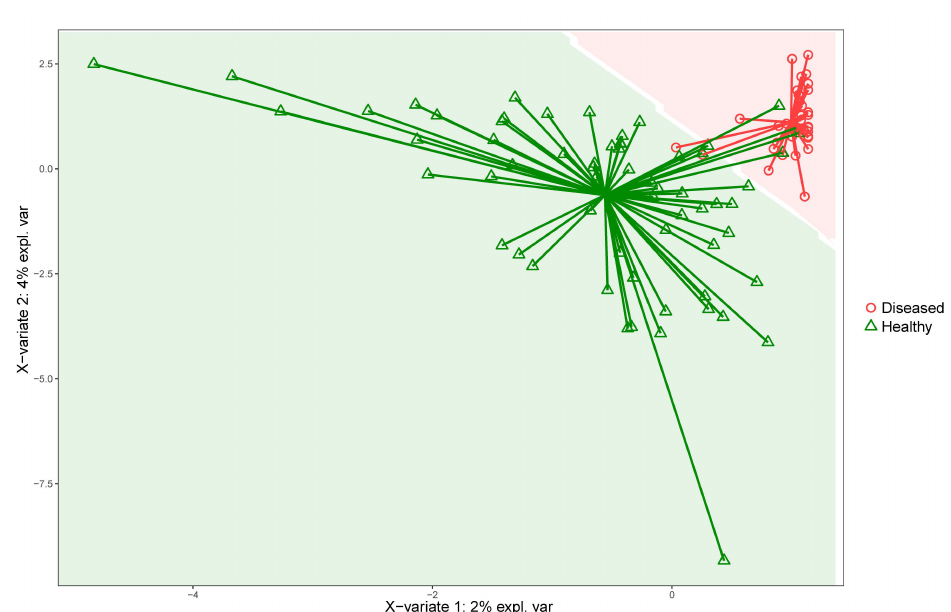
Figure 4. Sample prediction area plot from the sPLS-DA model applied at species level (training set: 65%; test set: 35%). Samples are classified into two classes: diseased (red) and healthy (green). To visualize the prediction area, the plot background was colored according to the predicted classification area.